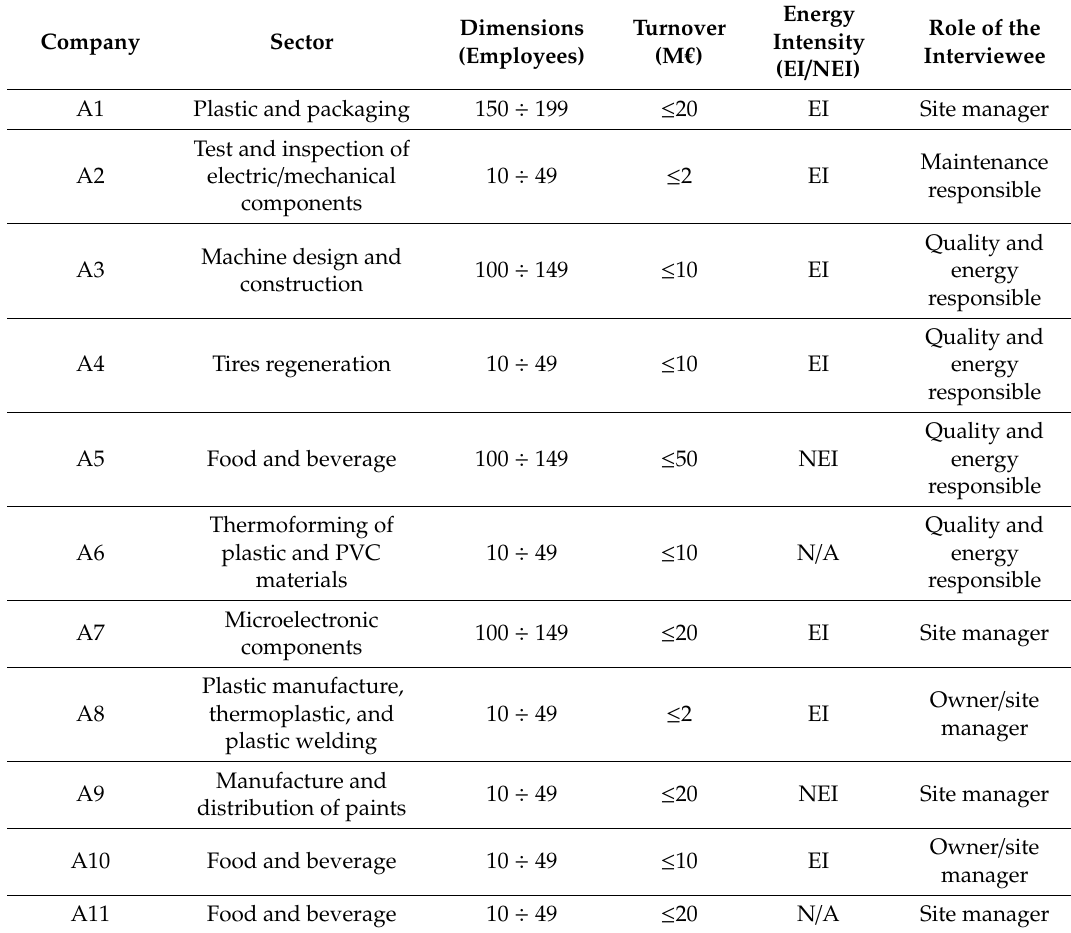
Table 7. Heterogeneity of the sample for the framework